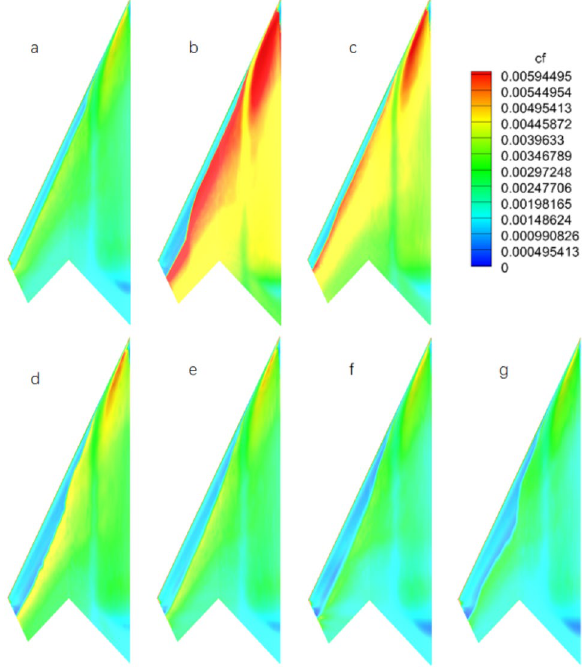
Figure 11. Friction coefficient distributions on the lower surface of flying wing model with wall temperature ( M = 0.9, α = 2°): (a) adiabatic wall; (b) T ∗ w = 0.172; (c) T ∗ w = 0.344; (d) T ∗ w = 0.687; (e) T ∗ w = 1.031; (f) T ∗ w = 1.375; (g) T ∗ w =